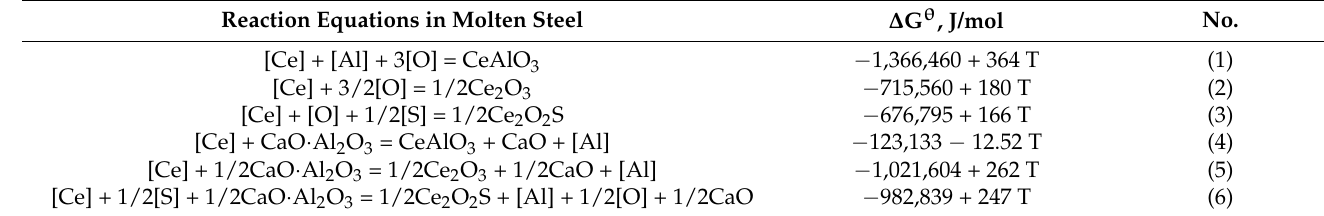
Table 3. Possible reactions in steel after Ce addition and their standard Gibbs free energy [26,27].